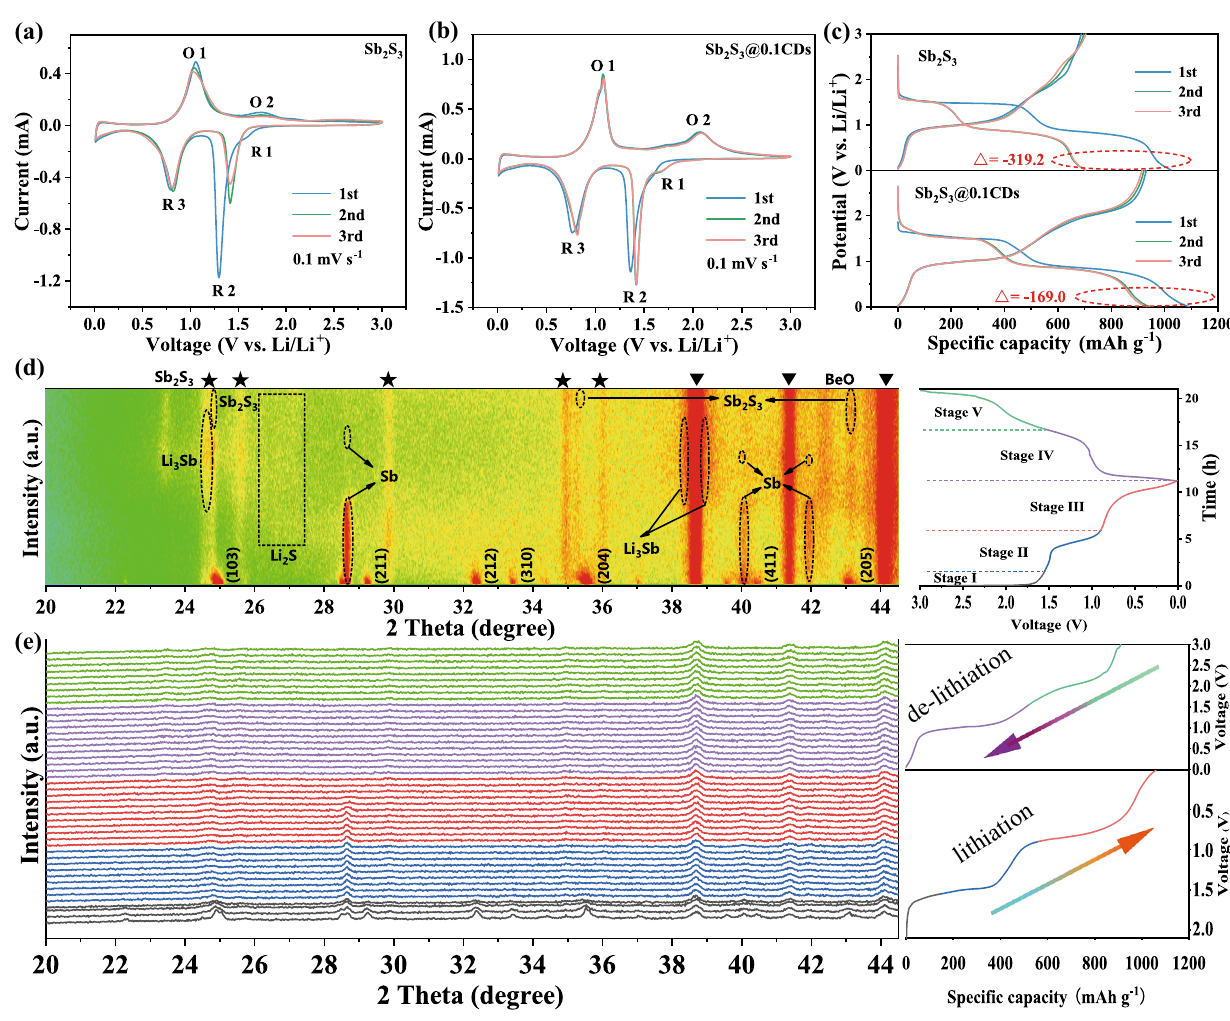
Fig. 6 Mechanism analysis of the lithium storage process. CV curves at a scan rate of 0.1 mV s −1 of a Sb 2 S 3 electrode and b Sb 2 S 3 @0.1CDs electrode. c GCD curves at 0.1 A g −1 of stibnite Sb 2 S 3 and Sb 2 S 3 @0.1CDs electrodes. d, e In situ XRD patterns of Sb 2 S 3 @0.1CDs electrode with the corresponding GCD curves at 0.1 A g −1 during the first